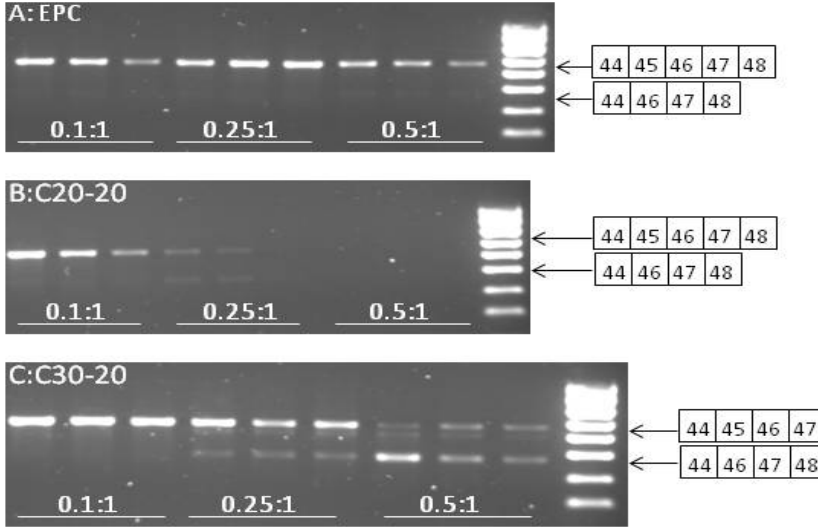
Figure 4. ( A )–( C ) Comparison of efficiency of various lipid/PMO AO complexes (each performed in triplicate) to induce skipping of exon 45 in RNA from hSkMCs. Nested RT-PCR was performed on 200 ng from hSkMCs treated with lipoplex formulations, EPC/Chol/PMO ( A ), C20-20/Chol/PMO (B) and C30-20/Chol/PMO ( C ) at 250 nmol/L at the ratios indicated. The obtained products were separated by agarose gel (1.5%) electrophoresis against Hyper ladder IV. The full-length product (exons 44-48) is 657 bp and the skipped product (exons 44, 46-48) is 481 bp in size. Non-transfected controls are shown in D